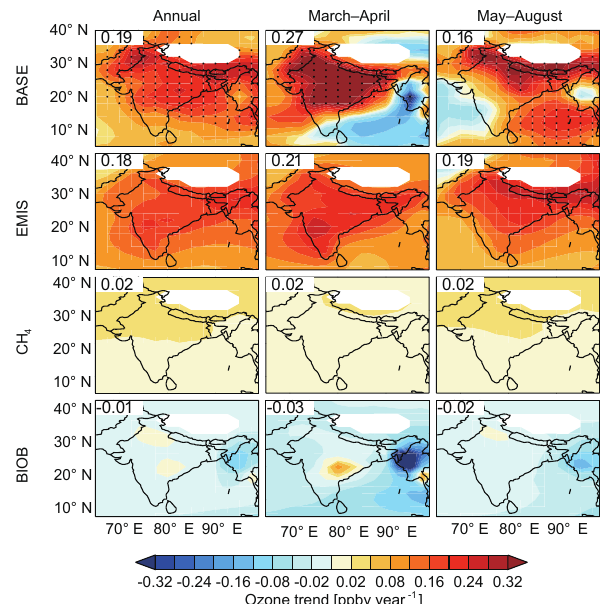
Figure 9. Simulated (1990–2010) trends in lower tropospheric ozone and factors contributing to simulated trends. Trends are cal- culated for annual averages (left column), pre-summer monsoon seasons (central column), and summer monsoon seasons (right col- umn). Values inset are mean trend in ppbvyr − 1 averaged over the Indian land. Black dots in the first rows denote significant trends in BASE simulations. Trends contributed by interannual changes in anthropogenic emissions (EMIS), global methane concentrations (CH 4 ) , and biomass burning emissions (BIOB) are